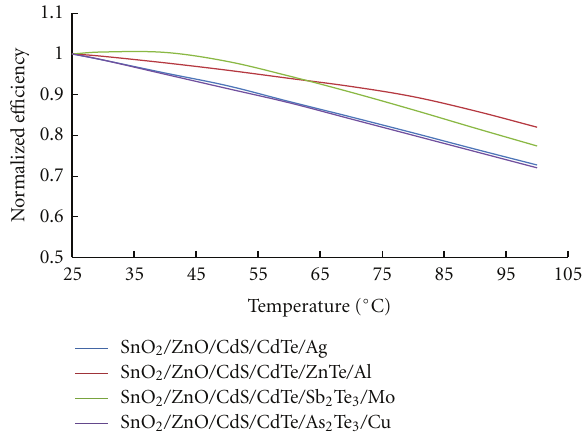
Figure 9: E ff ects of operating temperature on the proposed cell